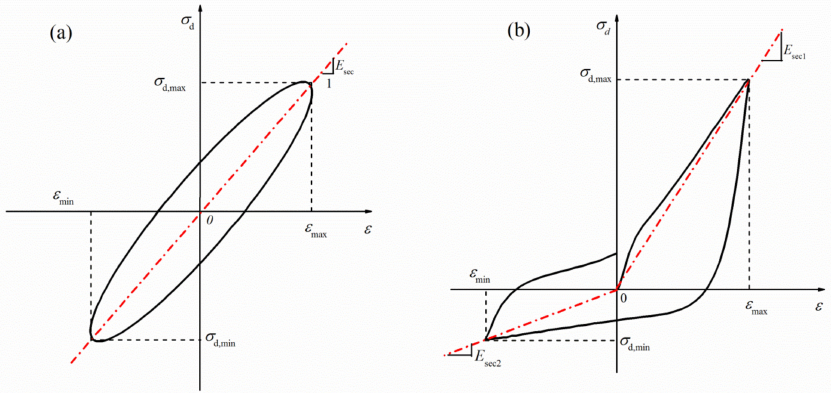
Figure 4. Symmetrical ( a ) and asymmetrical ( b ) hysteresis